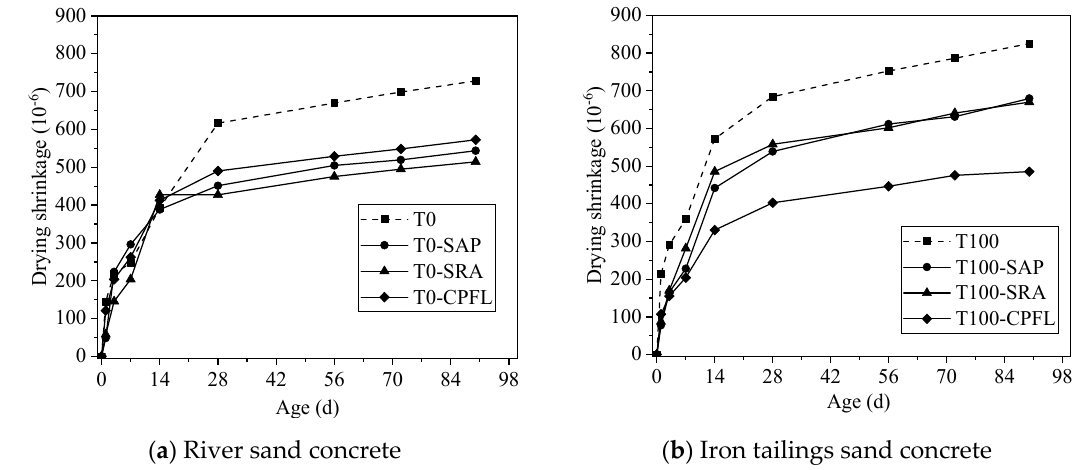
Figure 9. Effects of shrinkage mitigation methods on drying shrinkage of concrete. Figure 9. E ff ects of shrinkage mitigation methods on drying shrinkage of